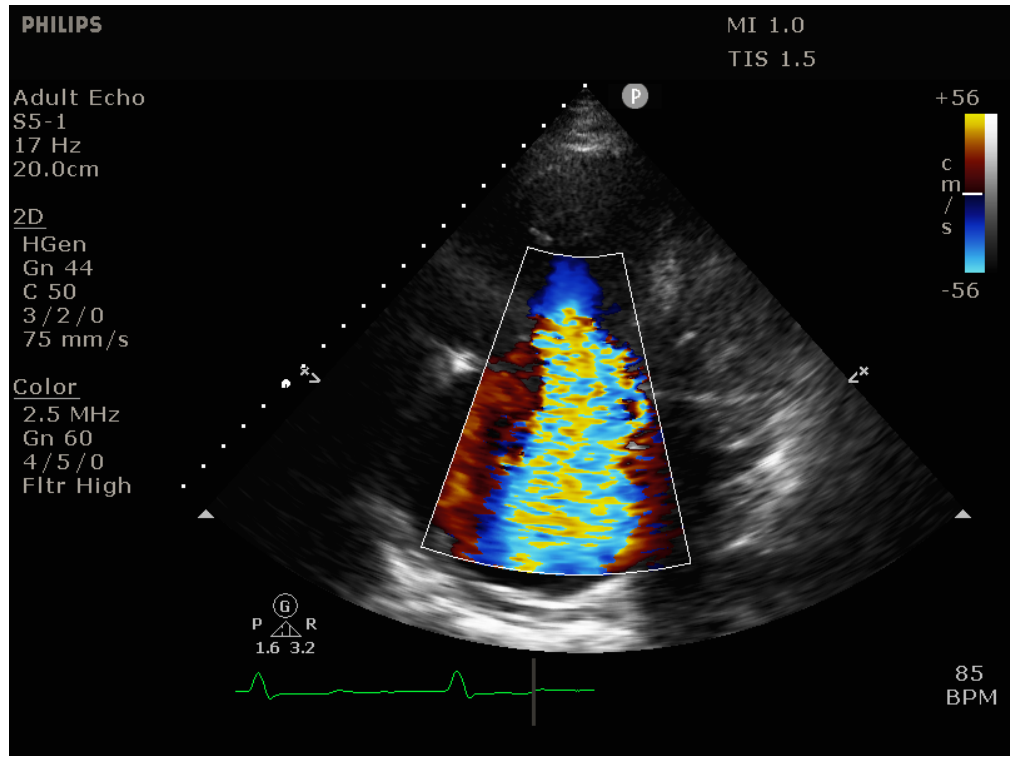
Figure 5. Transthoracic echocardiogram (apical 4-chamber view) showing severe tricuspid regurgitation due to massive RV dilation.